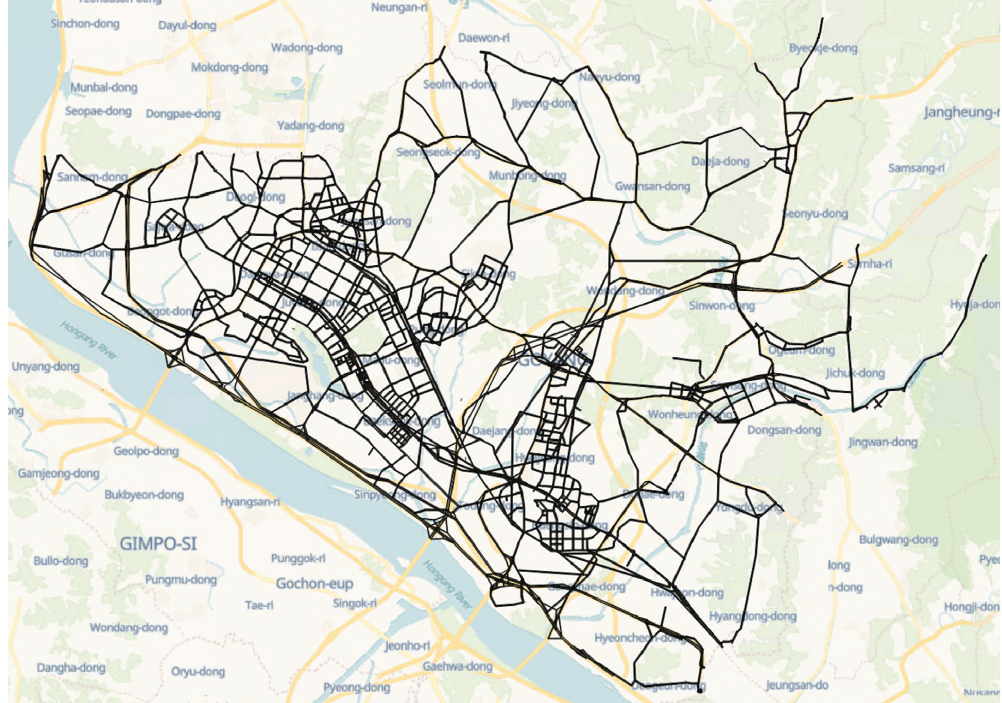
Figure 13: Goyang transit network (Gyeonggi province, South Korea).